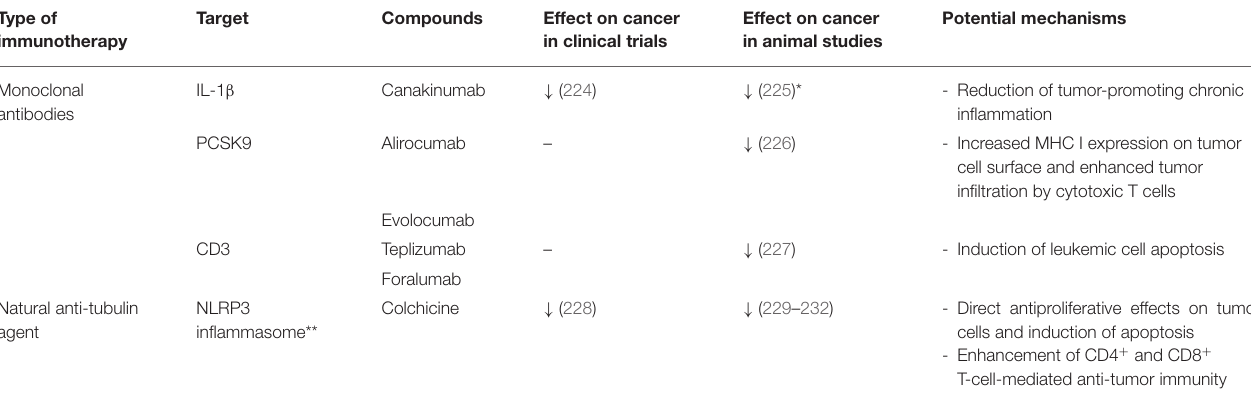
TABLE 2 | Effects of anti-atherosclerotic immunotherapies (with clinically proven efficacy) on cancer. Type of